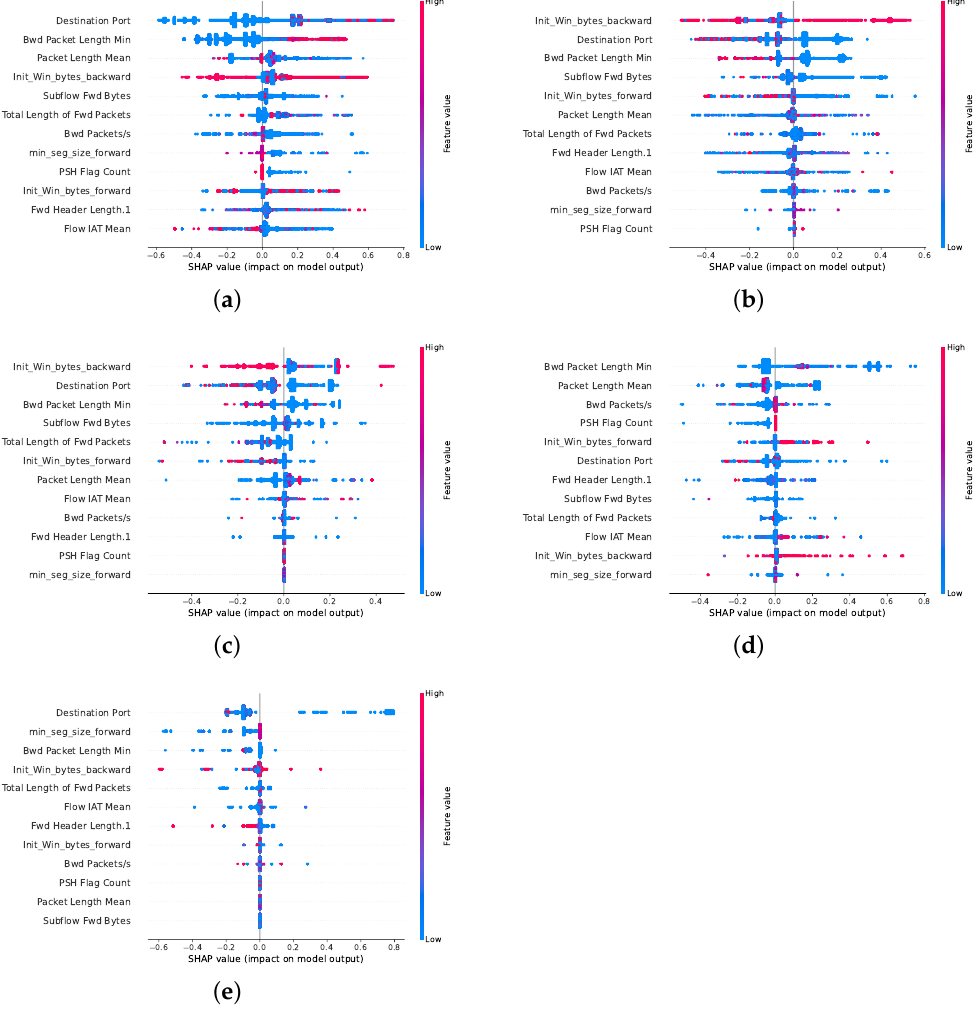
Figure 4. Summary plots. ( a ) Benign; ( b ) Dos; ( c ) DDos; ( d ) Port scan; ( e ) Brute